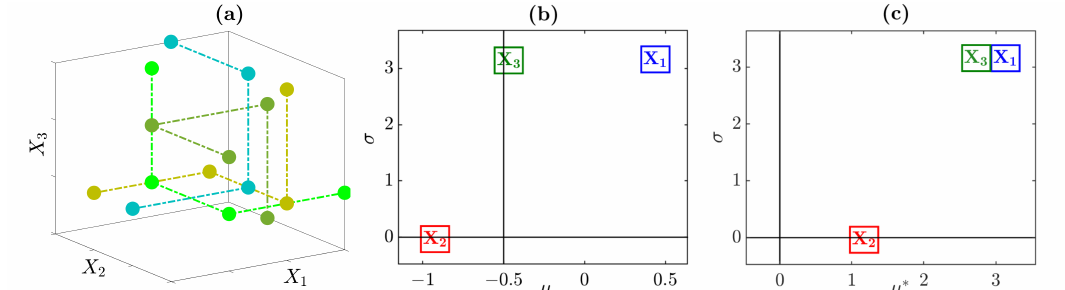
Figure 4. ( a ) Example of four random trajectories of the Morris method for the toy example obtained with p = 3 and ∆ = 2 ( b , c ) Morris plots— ( ˆ µ i , ˆ σ i ) and ( ˆ µ ∗